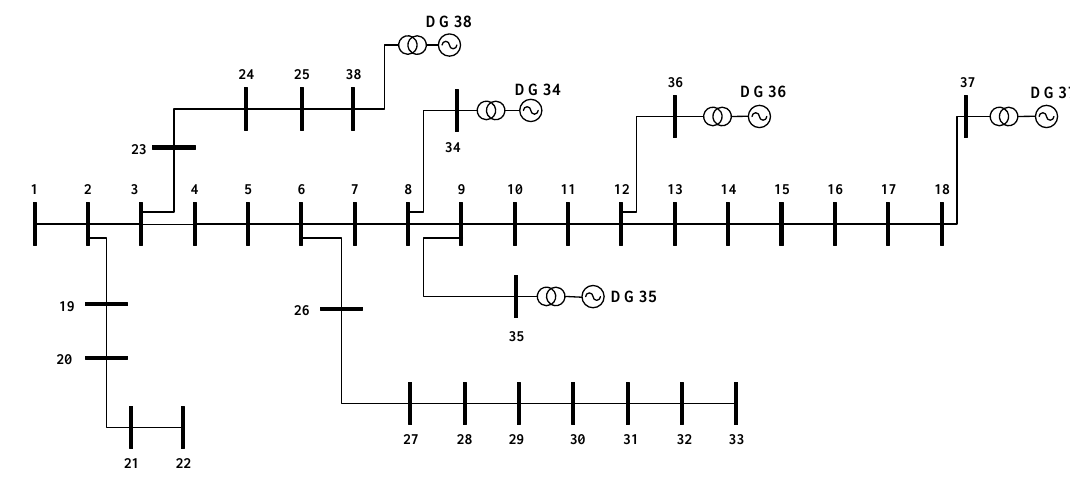
Figure 2. The 38-bus power distribution system under study. Table 1. Simulation Parameters of the